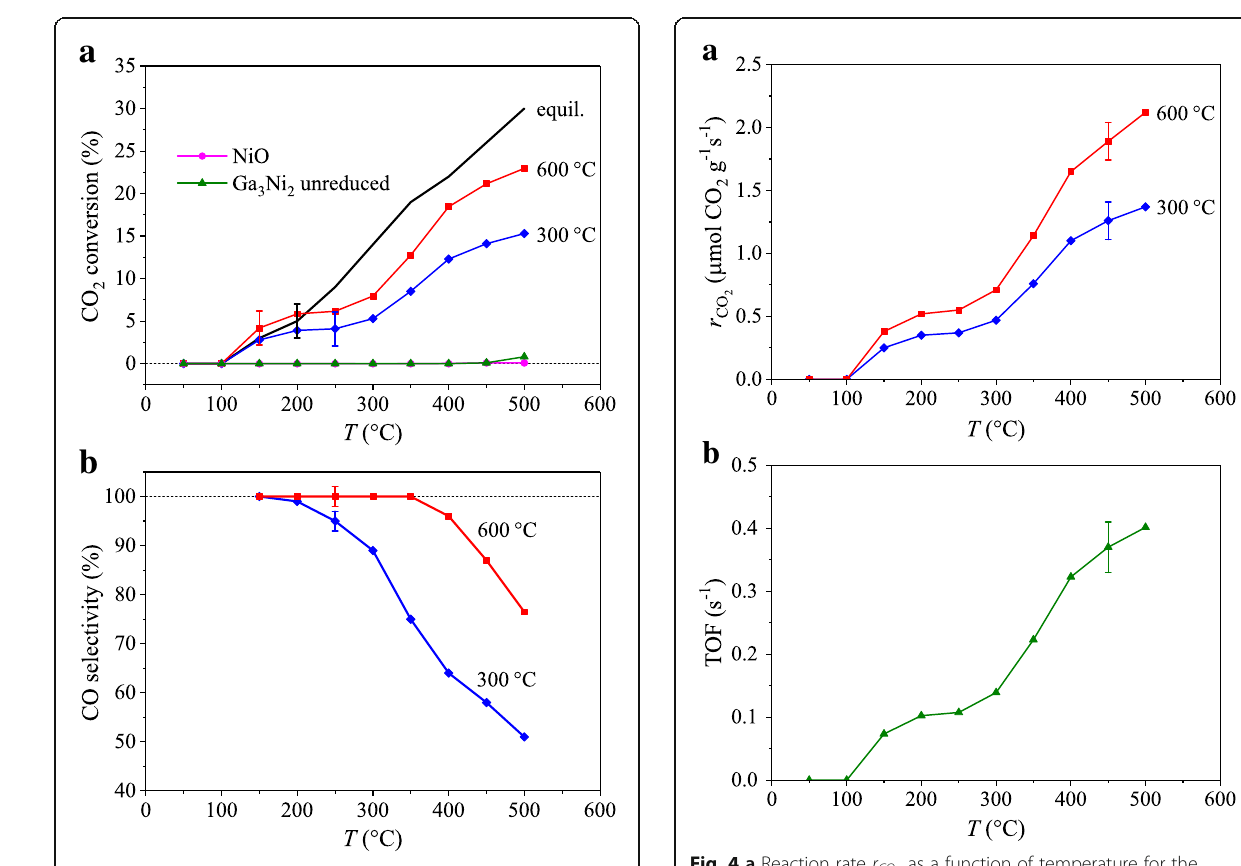
Fig. 3 a CO 2 conversion data over the Ga 3 Ni 2 catalyst reduced at 300 or 600 °C, respectively (CO 2 :H 2 ratio of 1:1, GHSV = 60,000 h − 1 ). The equilibrium conversion of the rWGS reaction is shown by the black solid curve (Kim et al. 2012, 2013). Conversion over the nickel oxide NiO and the unreduced Ga 3 Ni 2 was also tested, showing no activity within the investigated temperature range. b CO selectivity data over the Ga 3 Ni 2 catalyst reduced at 300 or 600 °C, respectively